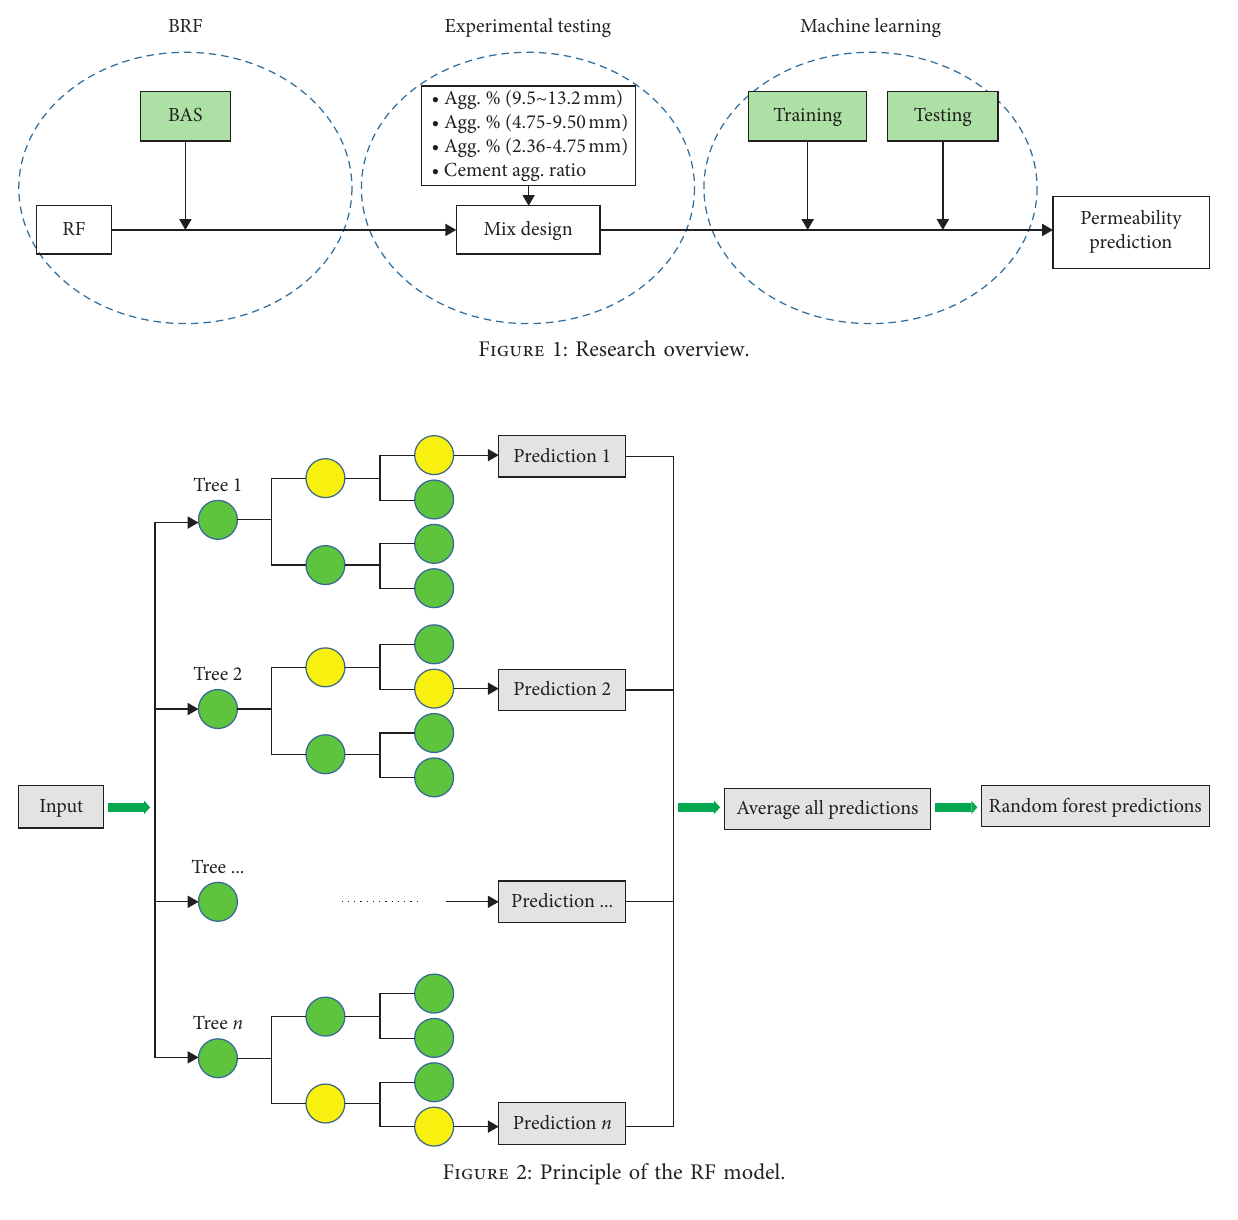
Figure 2: Principle of the RF